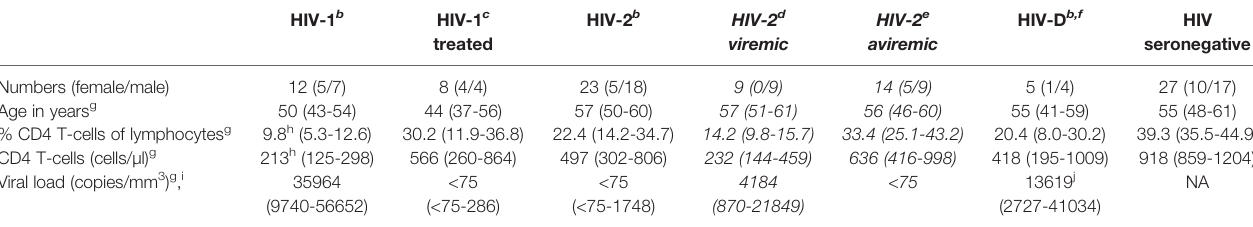
TABLE 1 | Characteristics of study participants a